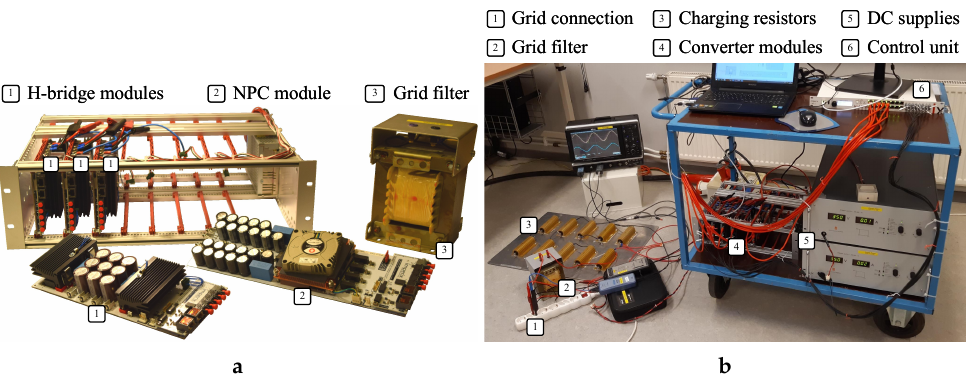
Figure 7. ( a ) Converter modules and grid filter. ( b ) Actual laboratory arrangement of the 33-level, grid-tied asymmetric